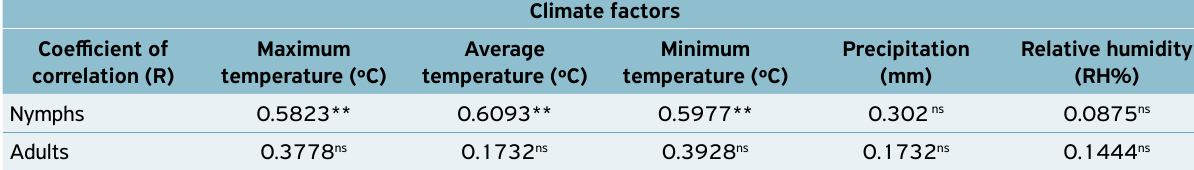
Table 3. Coefficient of correlation (R) between climatic factors and population of nymphs and adults of Vatiga illudens (Hemiptera: Tingidae), present in the cassava crop from January 2011 to June 2012, Dourados, Mato Grosso do Sul.